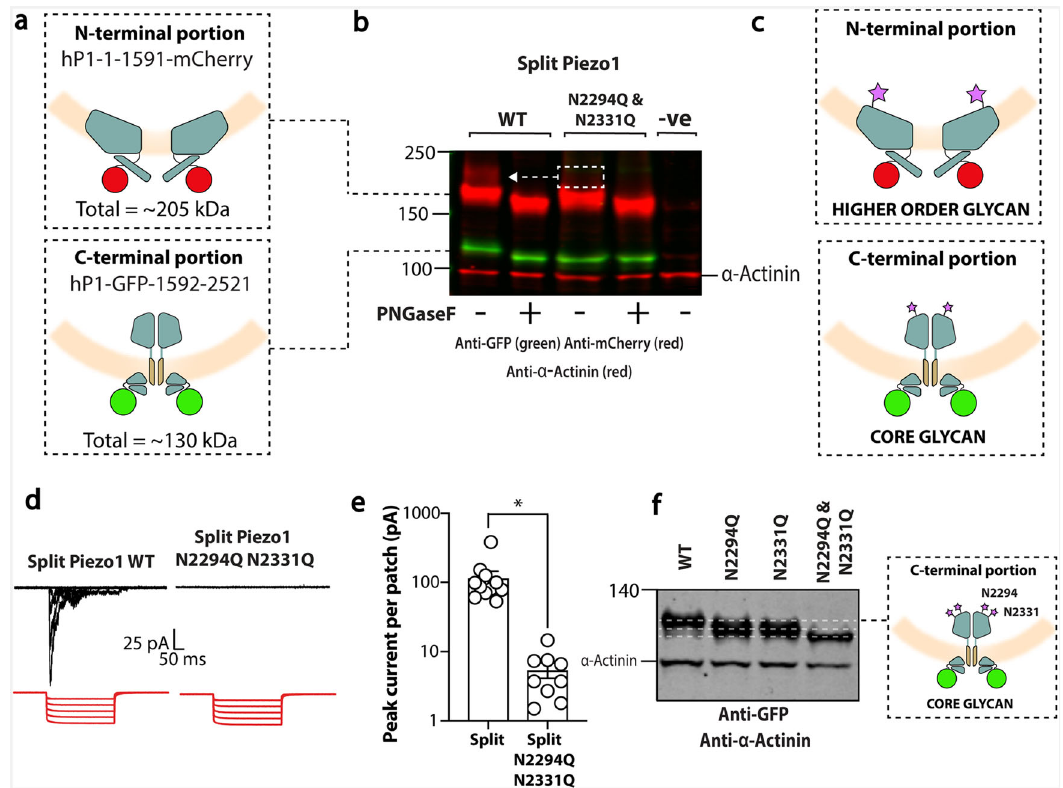
Fig. 5 N-glycosylation of Piezo1 in a split construct. a Diagram depicting the human split Piezo1 protein. b Representative blot showing the split human Piezo1 protein and the split human Piezo1 protein with the double cap mutant N2294Q and N2331Q with and without PNGaseF treatment. c Diagram illustrating where glycans are likely to be located. d Electrophysiological recordings of Piezo1 − / − HEK293T cells expressing human split Piezo1 and the double cap mutant N2294Q and N2331Q in the cell-attached con fi guration in response to negative pressure applied using a high-speed pressure-clamp (red). e Quanti fi cation of peak current elicited per patch. f Representative blot showing the C-terminal portion of the split human Piezo1 protein and the mutants N2294Q, N2331Q and N2294Q/N2331Q. Note that the single mutants run at the same size but the double mutant is smaller. * p < 0.05 determined by Mann – Whitney U -test. − ve represents an un-transfected